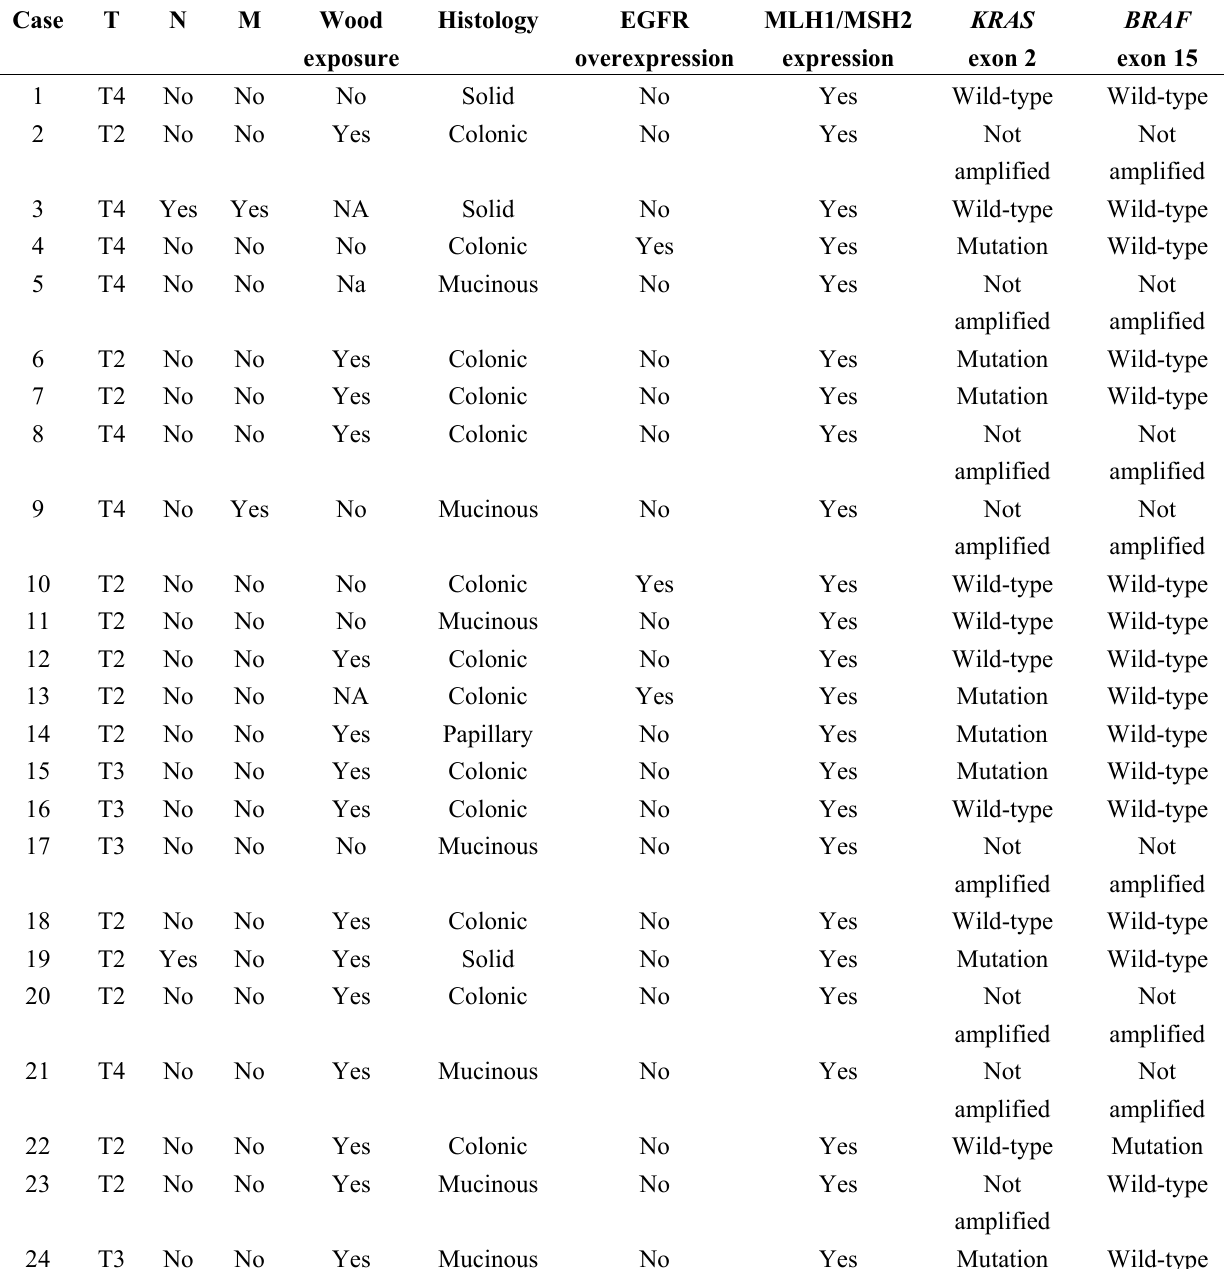
Table 2. Demographic, clinicopathologic and, genetic alterations, and follow-up data of ITAC